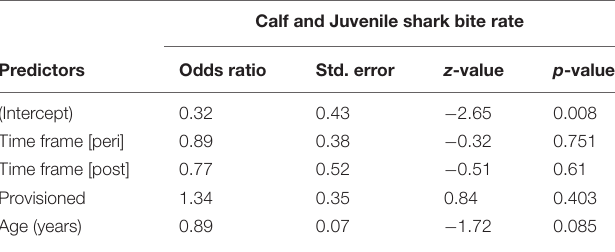
TABLE 5 | Annual probability of receiving a shark wound for offspring of non-provisioned and provisioned seagrass specialists up to age 10, before, during, and after the